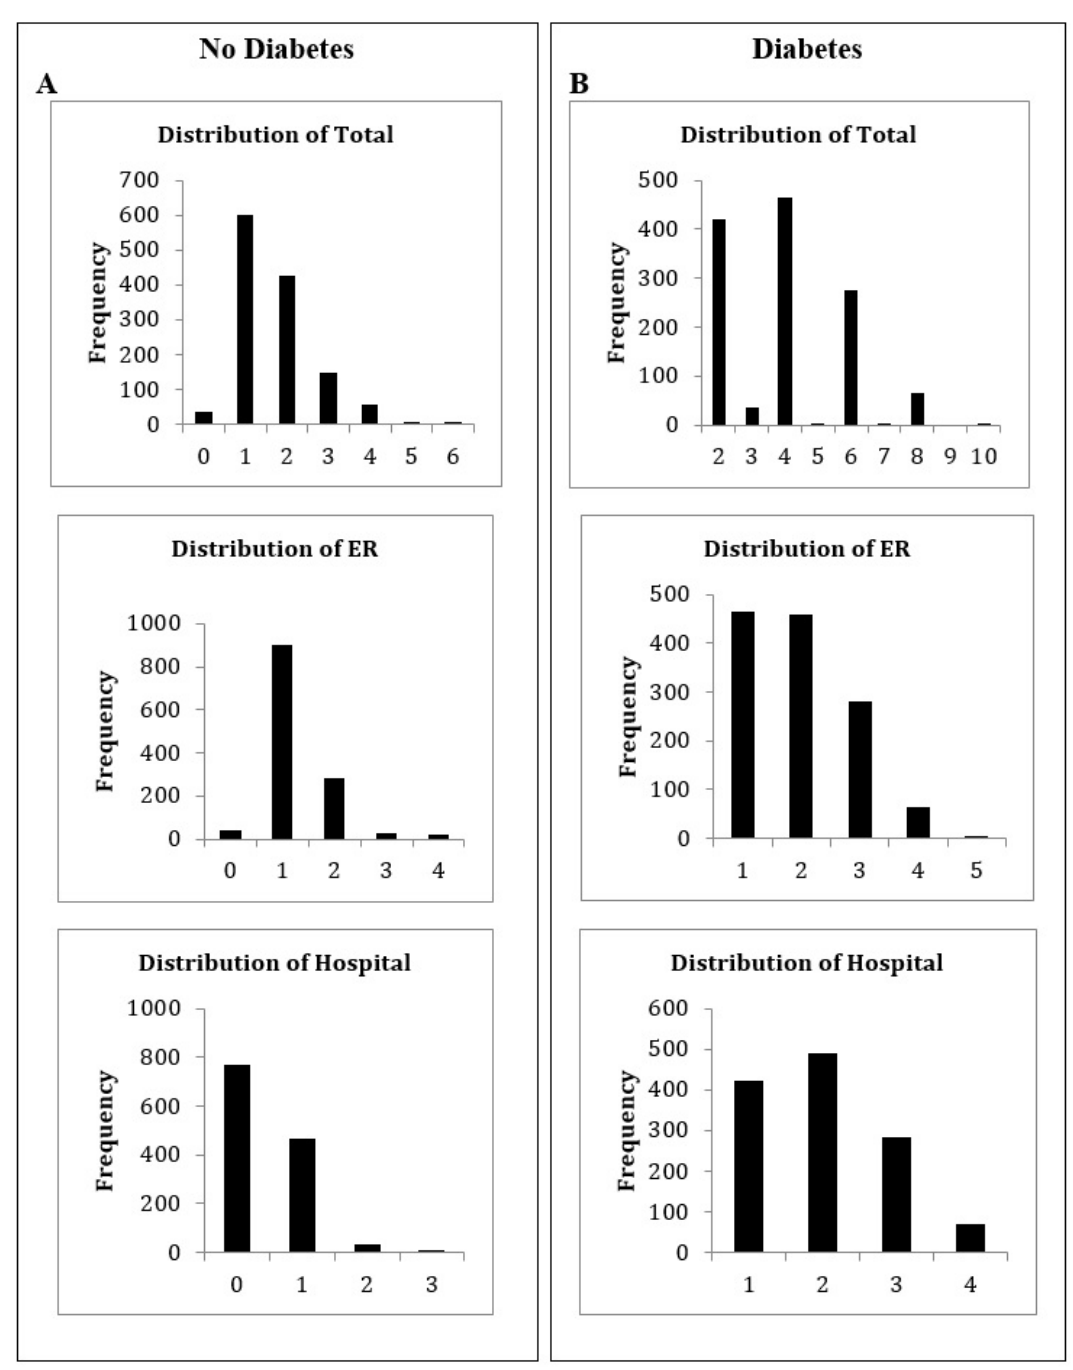
Figure 1. Histograms of Exacerbations The frequency of hospitalization and emergency room care for A) non-diabetics and B) those that developed diabetes. Statistical analysis of differences between groups is presented in Table